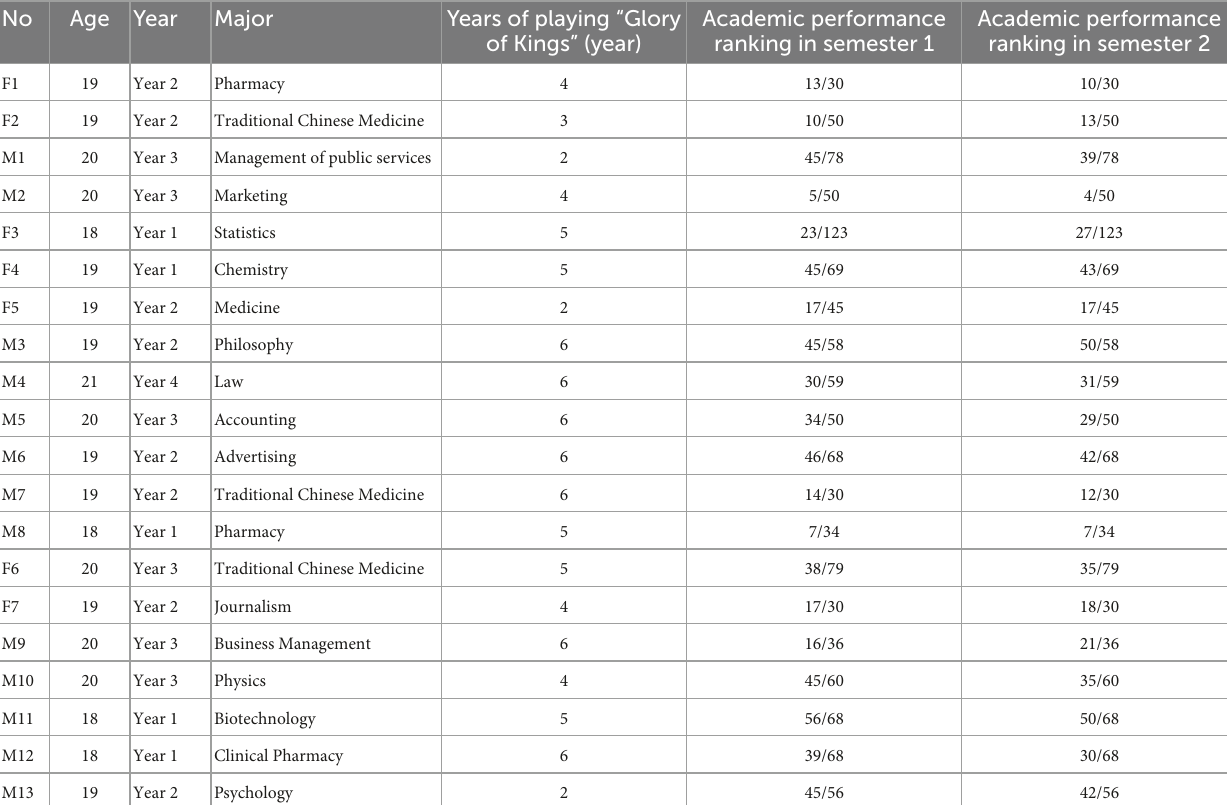
TABLE 1 The basic information of the “Glory of Kings” player